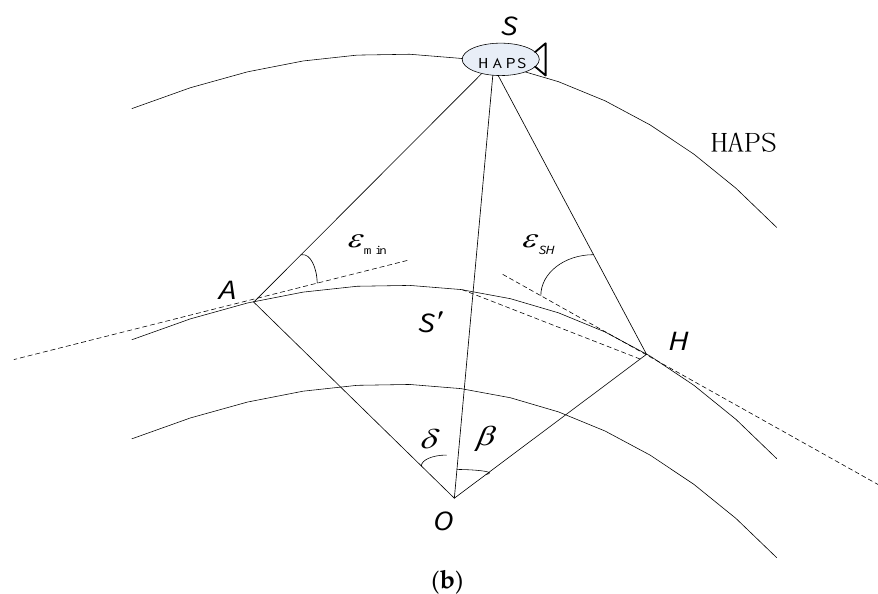
Figure 2. Space network diagram and link geometry of HAPS. ( a ) Network diagram; ( b ) Geometry diagram.